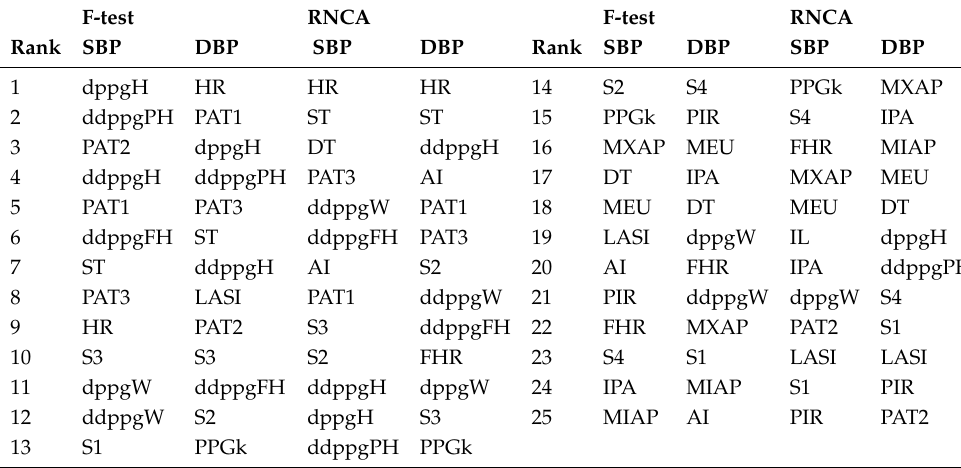
Figure 4. The weighted feature sets were obtained using the F-test and RNCA algorithms, where ( a , b ) denote the ranked features acquired using the F-test and ( c , d ) were obtained from the RNCA. Table 4. The high-score ranked features were selected using the F-test and RNCA algorithms for the SBP and DBP